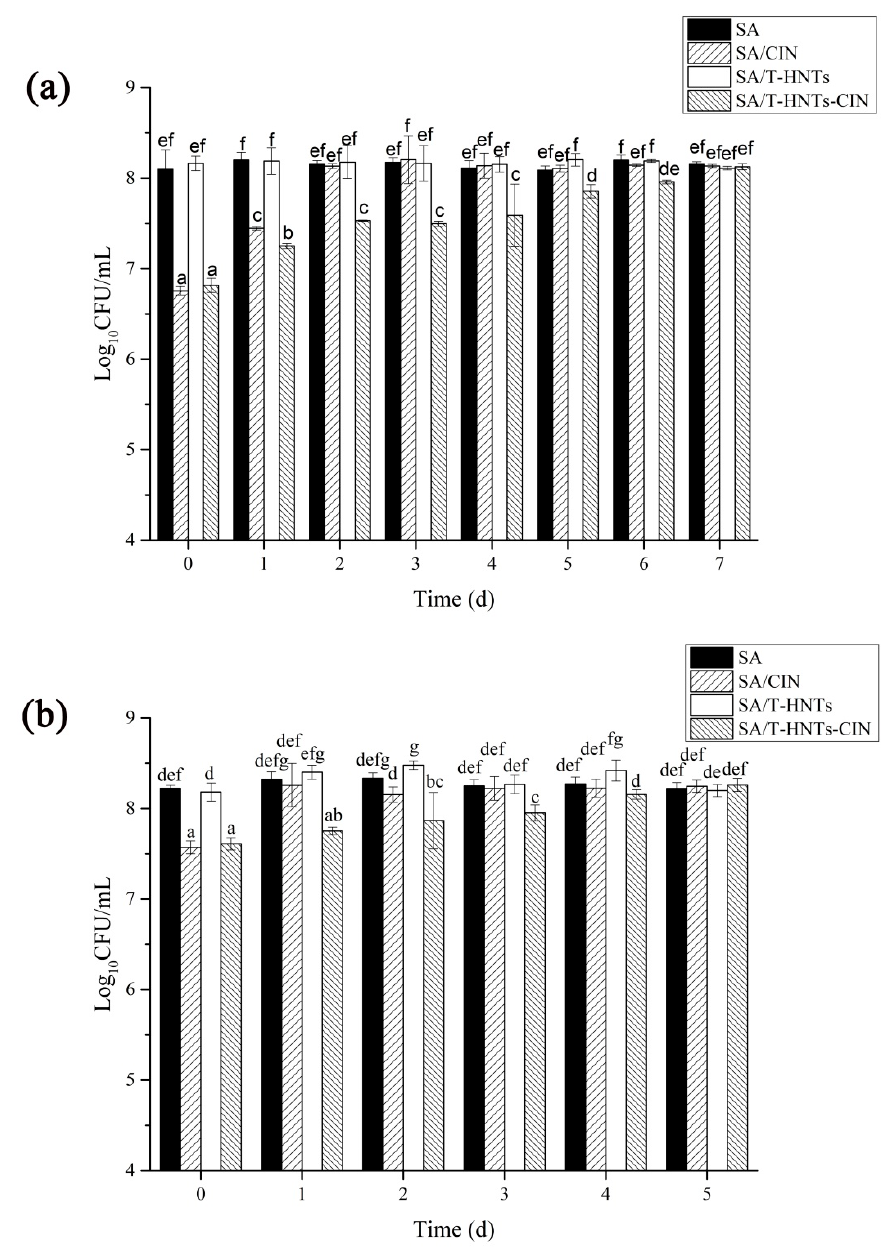
Figure 5. Antimicrobial activity of the composite film: ( a ) Staphylococcus aureus and ( b ) Escherichia coli. Values followed by different letters (a–f) were significantly different ( p < 0.05), where a is the lowest value.